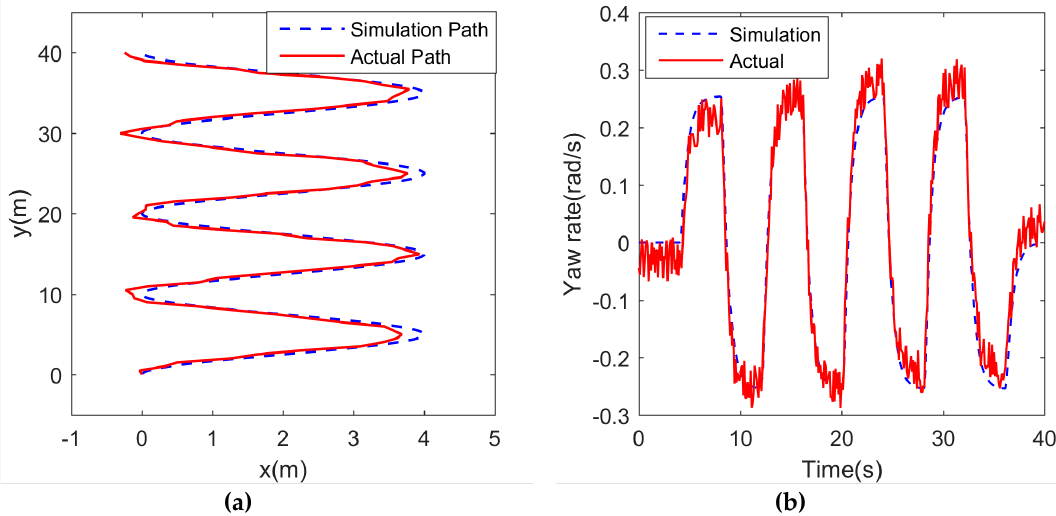
Figure 10. The experimental results of the zigzag test: ( a ) the zigzag simulation path and actual path; ( b ) the result of simulation and actual yaw rate in zigzag test.